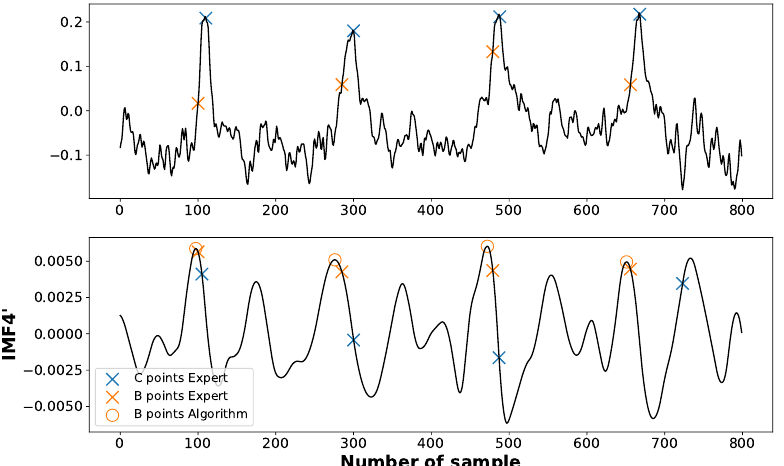
Figure A4. An example of B point misidentification caused by too a small distance between the B and C points.